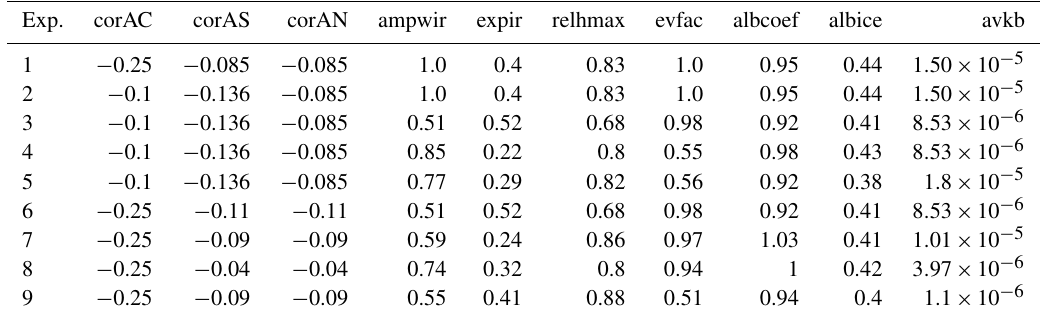
Table A1. For the individual experiments of the perturbed-parameter ensemble of i LOVECLIM, the values of the 10 perturbed parameters are given. Note that experiment 1 is the default. More information on the parameters is given in Table A2.